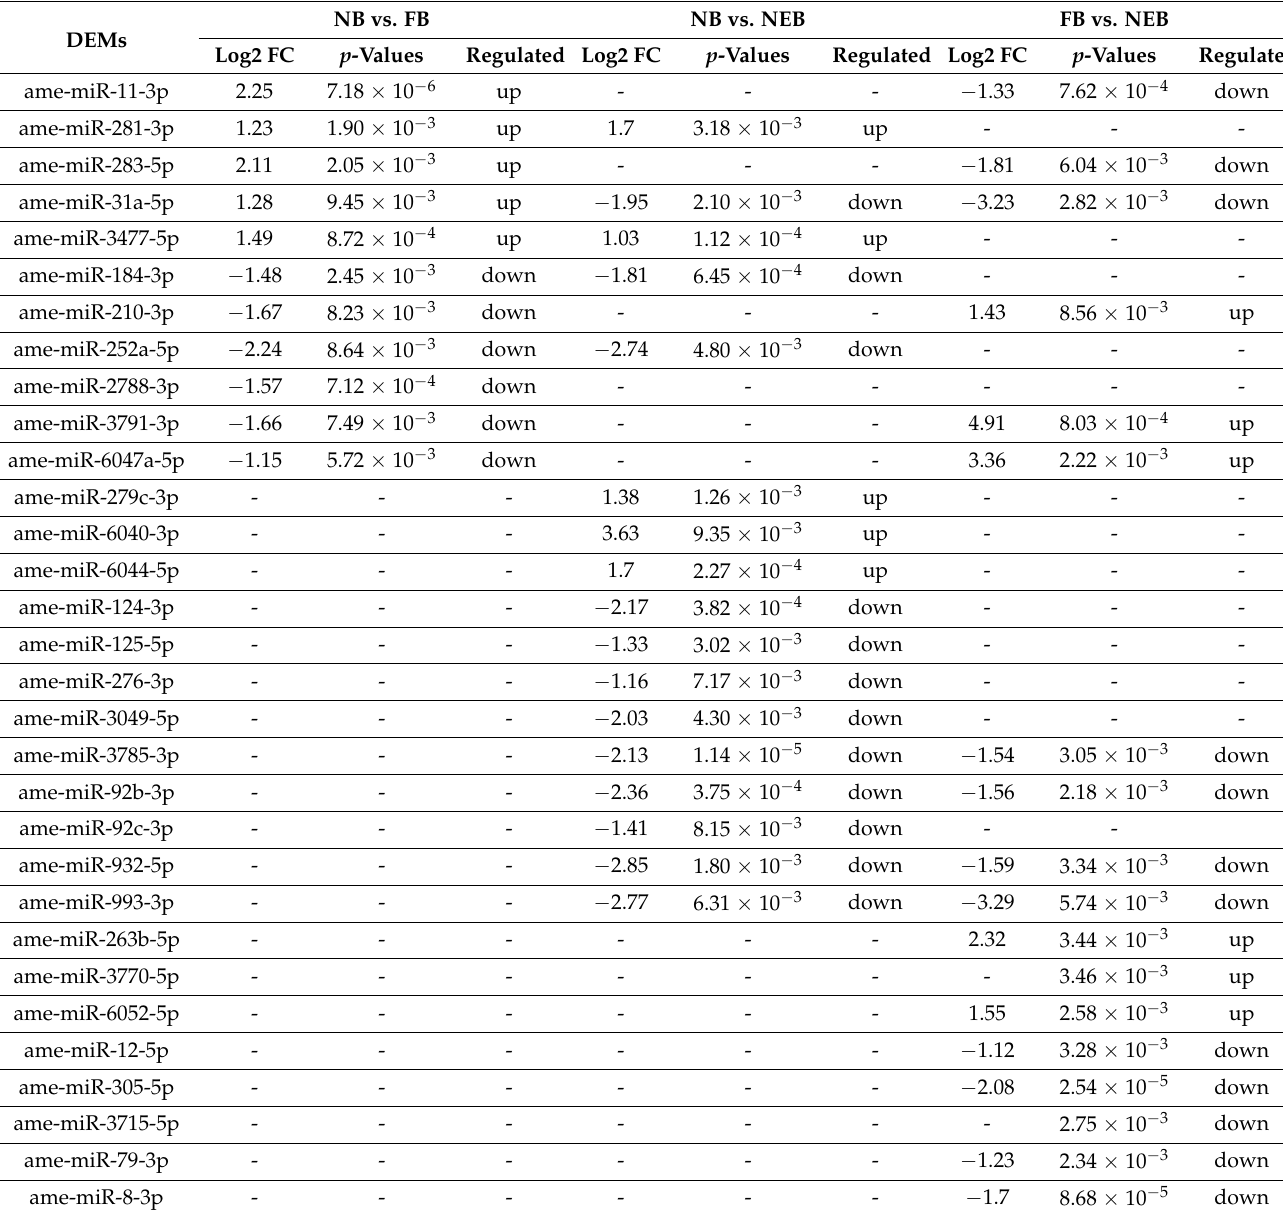
Table 3. Differentially expressed miRNAs among nurse bee, forager bee, and newly-emerged bee.